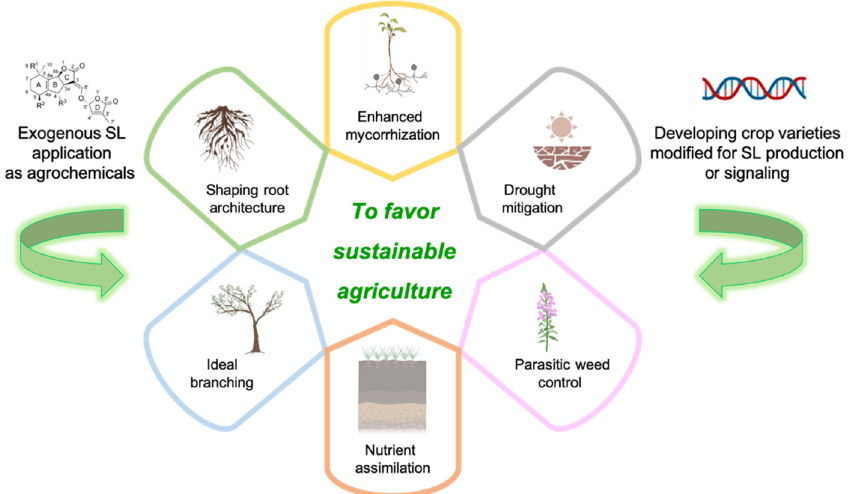
Figure 3. Agricultural applications of SLs. Exogenous applications of SLs as agrochemicals and the development of crops with modified SL production or signaling have the potential to favor sustainable agriculture via a number of mechanisms: shaping root architecture, promoting ideal branching, stimulating nutrient assimilation, controlling parasitic weeds, mitigating drought and enhancing mycorrhization. Created with BioRender.com.